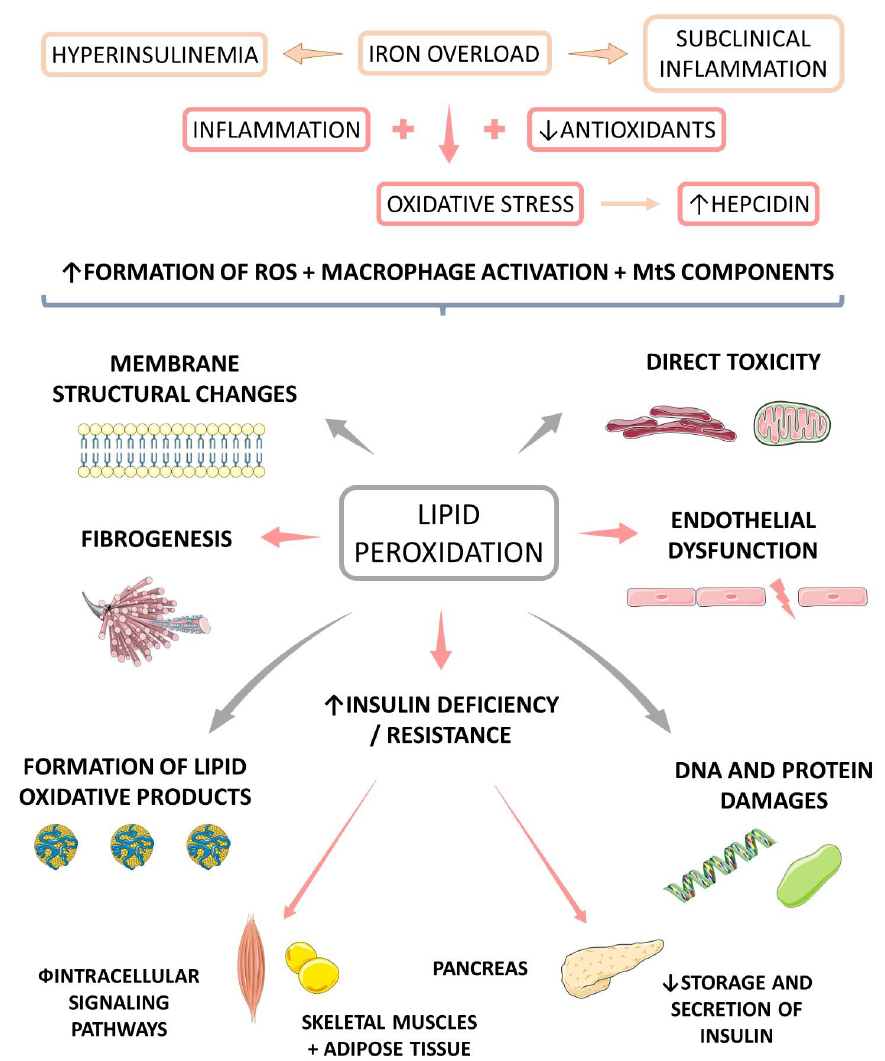
Figure 4. Iron overload increases oxidative stress and is related to the increase in hepcidin levels. Furthermore, oxidative stress is associated with lipidic peroxidation that interferes in insulin secretion and may lead to insulin resistance (IR), diabetes (DM), fibrogenesis, and endothelial dysfunction. Iron overload is also associated with hyperinsulinemia and subclinical inflammation. ROS: reactive oxygen species, MtS: metabolic syndrome, ↑ : increase, ↓ : decrease.